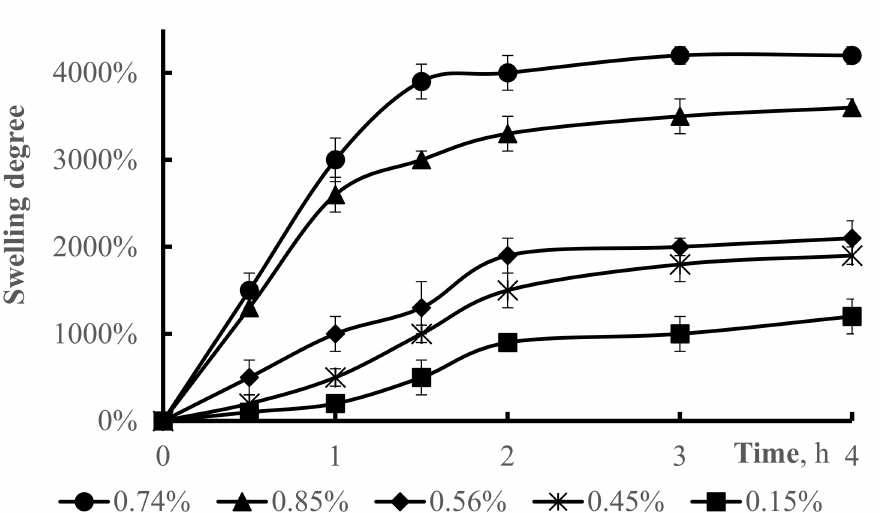
Figure 5. The effect of crosslinker concentration on the swelling degree of hydrogel. Hydrogel (50–50% DMAA–AMPS molar ratio, initiator concentration 0.07% of total monomer mass, total monomer concentration 5 M, reaction temperature 60 ◦ C) was